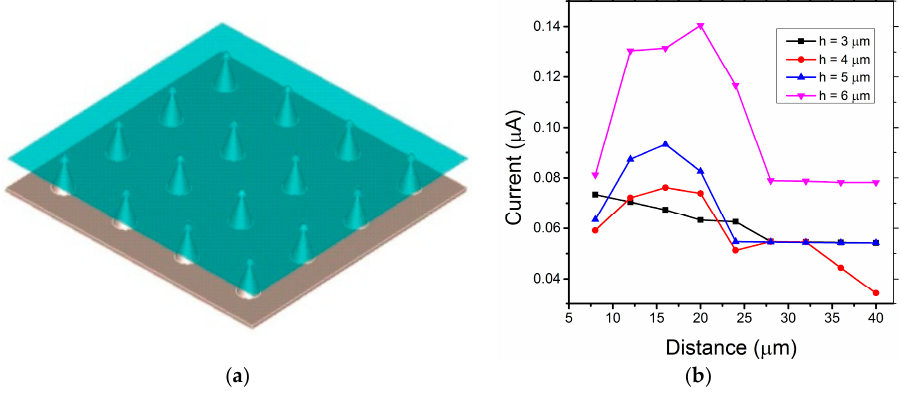
Figure 3. ( a ) Graphene-coated Mo tip array; and ( b ) field emission current as a function of H and D .